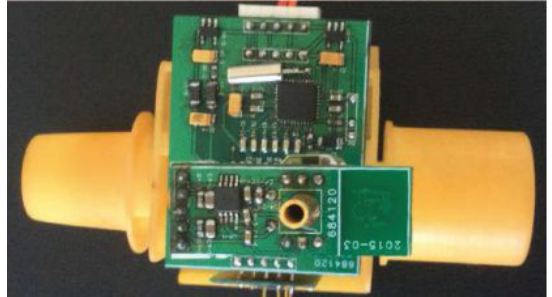
Figure 3. Equipment for respiratory